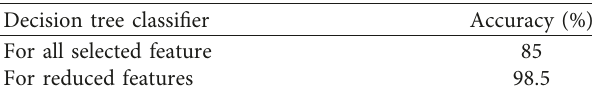
Table 10: Botnet detection technique result with all host